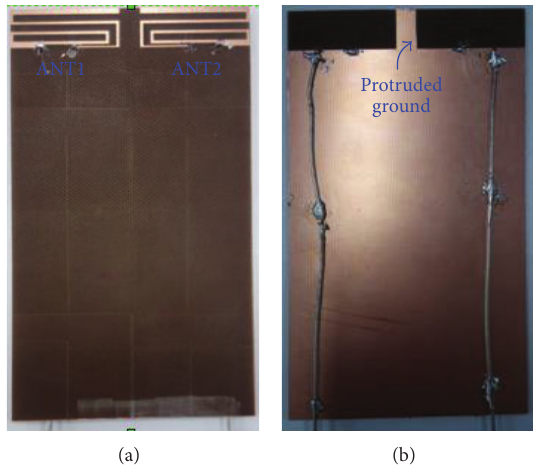
Figure 4: Manufactured planar antenna array for mobile phone